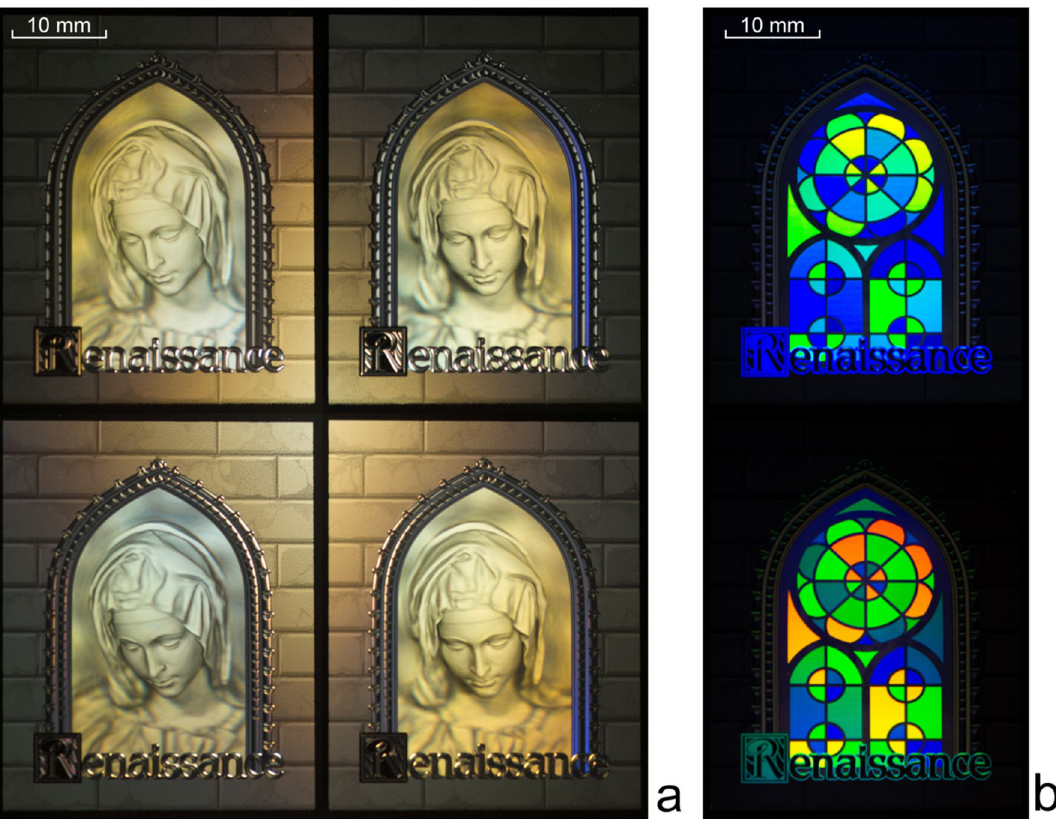
Figure 14. Photos and videos (see Supplementary Video S3 and Supplementary Video S4) of Example 2 at different positions of the light source and a fixed position of the sample and camera: ( a ) a 3D image is observed at diffraction angles within 30° and ( b ) a 2D colour image is visible at diffraction angle greater than